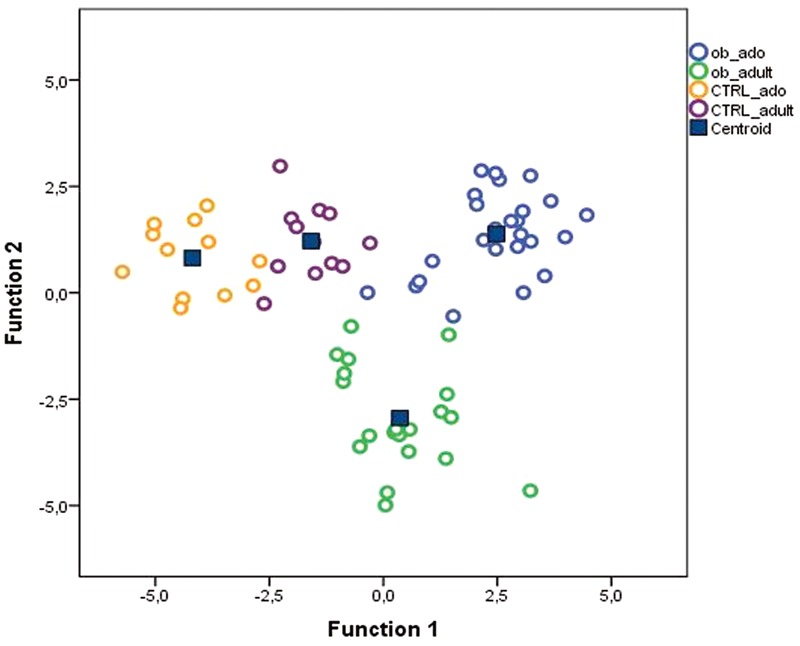
Canonical discriminant plot. Scatter plot of canonical discriminant analysis (DA) based on univariate ANOVA and Fisher’s coefficient applied to all OTUs of samples belonging to CTRL_ado, CTRL_adult, ob_ado, and ob_adult groups.